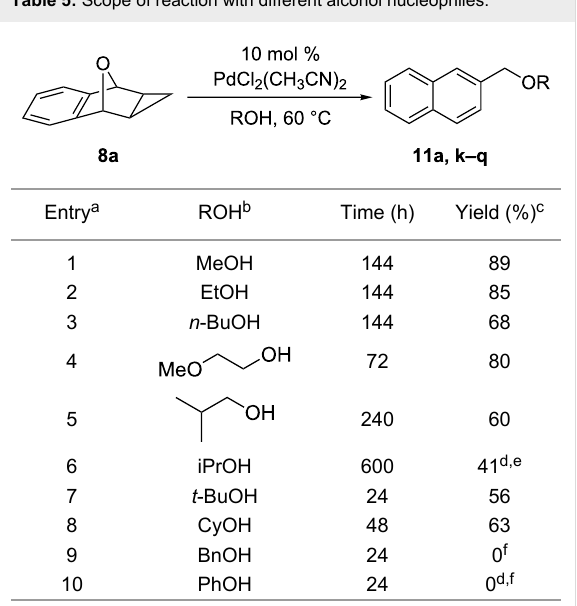
Table 5: Scope of reaction with different alcohol